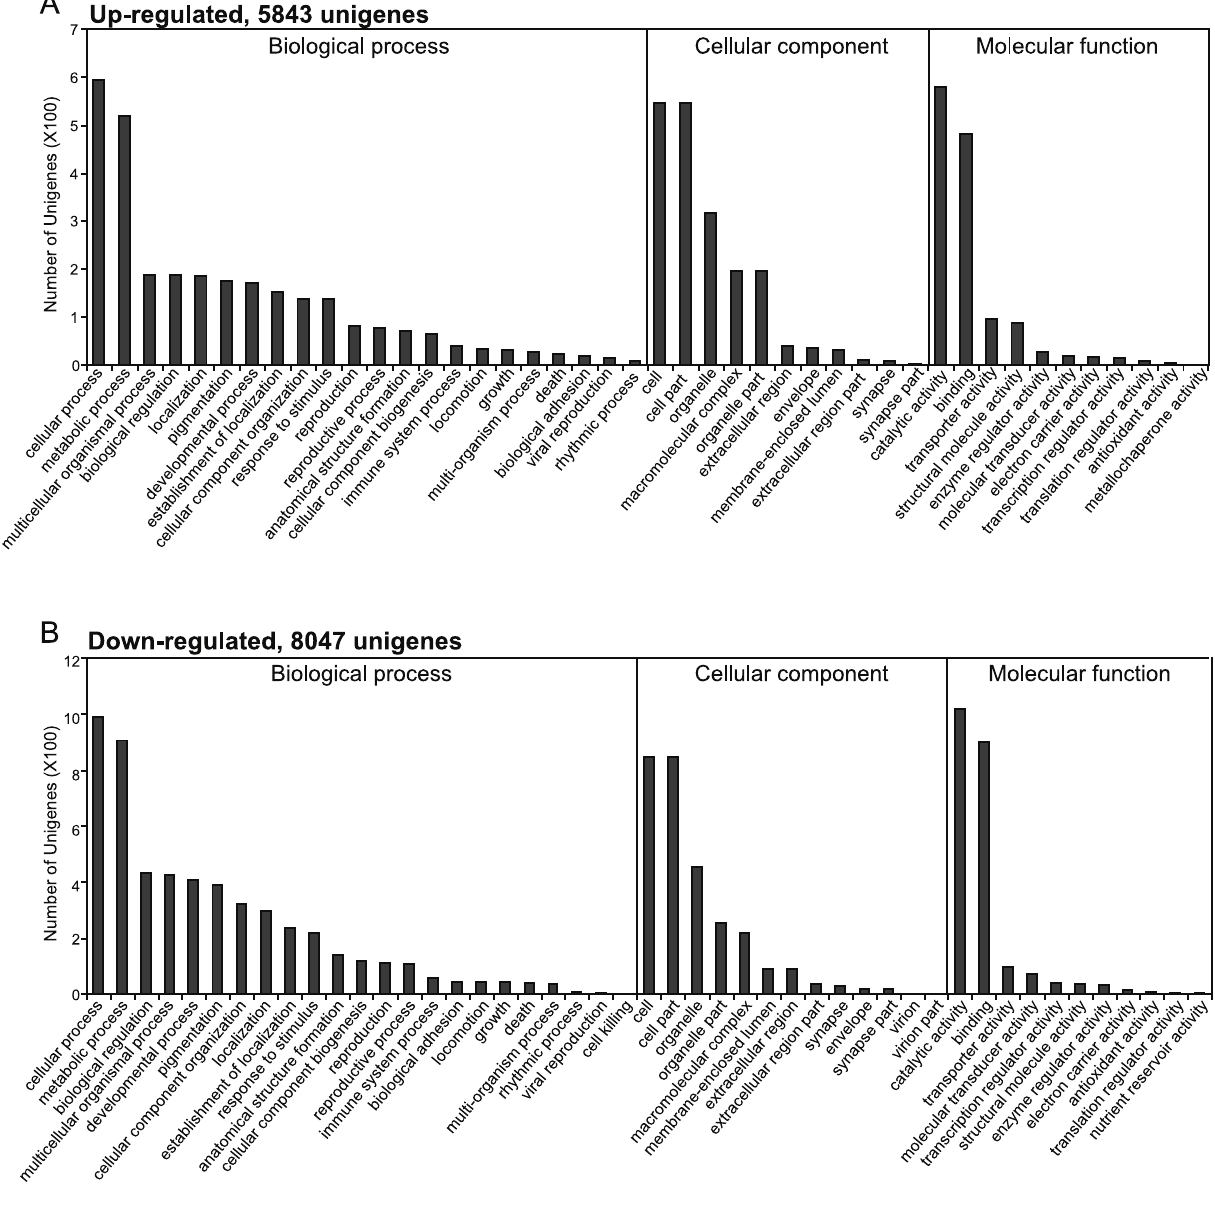
Figure 1. Gene ontology (GO) assignments for the enriched differently expressed unigenes after the infection of B.bassiana . (A) 5,843 up-regulated unigenes; (B) 8,047 down-regulated unigenes. The Y-axis shows the number of unigene in each GO term assigned at level 2.